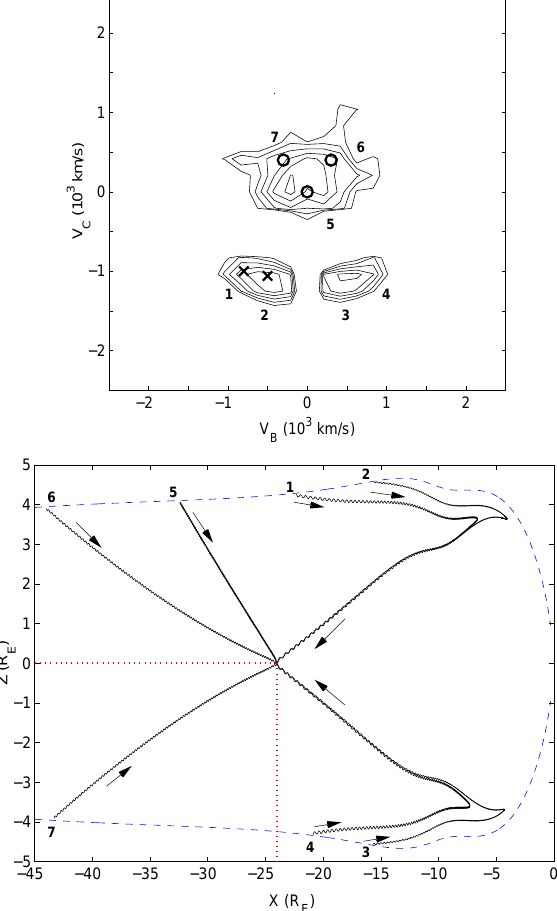
Fig. 15. (Top) Model two-dimensional ion velocity distribution in the V B − V C plane, calculated at (X,Y,Z) = ( − 24 , 0 , 0 . 0001 ) R E . At this location V B ≈ V z and V C ≈ V x . Several initial positions in velocity space are selected in order to demonstrate the representa- tive behaviour of particles comprising the different components of the distribution function. Particles from the convective phase space density enhancements (CPSDE), are labelled 1–4. The CPSDE at negative/positive V B is formed from mirrored ion beams that ini- tially come from the Northern/Southern Hemisphere. The phase space density of the negative V B CPSDE is slightly higher than its + V B counterstreaming counterpart. The lower figure shows the tra- jectory traces corresponding to the initial conditions chosen in the upper figure. Arrows show the direction of particle